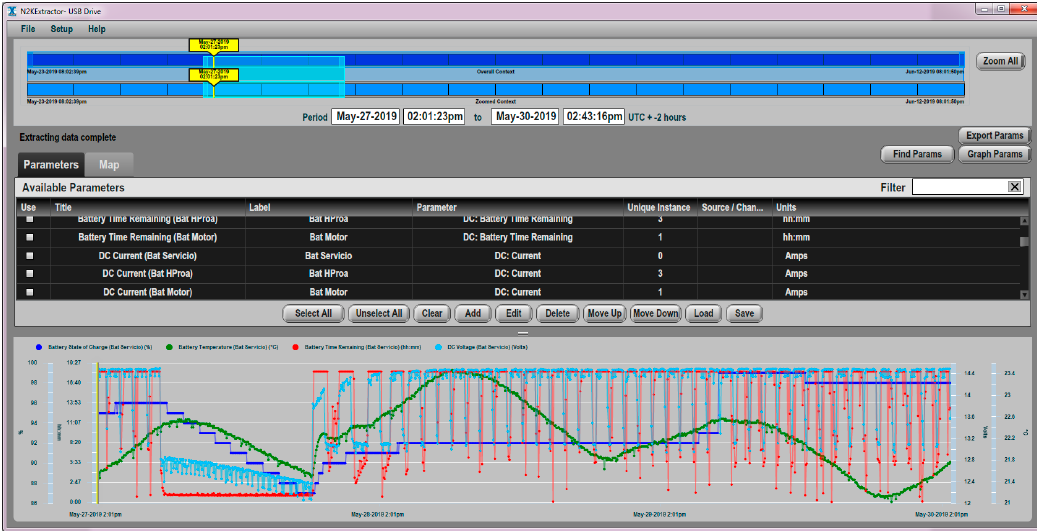
Figure 9. N2KExtractor workplace screen.